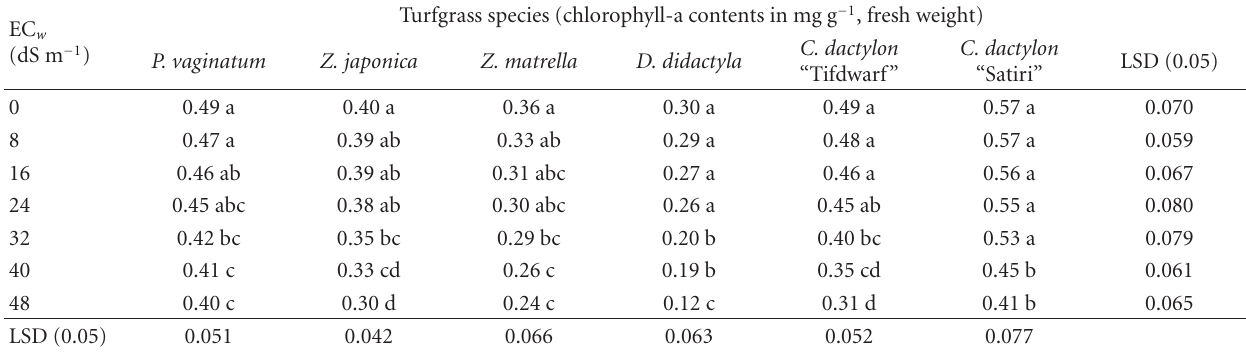
Table 6: E ff ect of salinity on chlorophyll-a concentration of six turfgrass species.